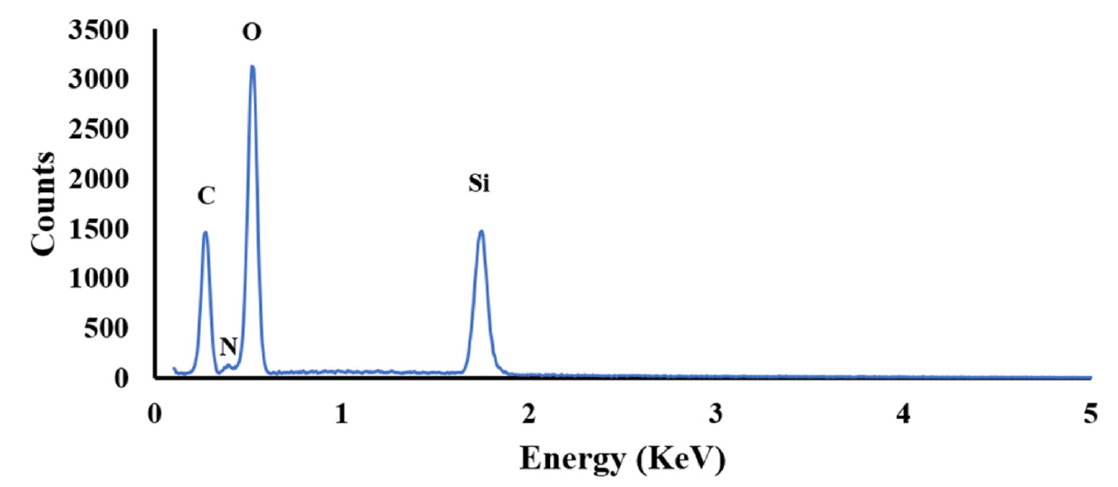
Figure 3. EDX spectrum for nanocomposite superhydrophobic coating .